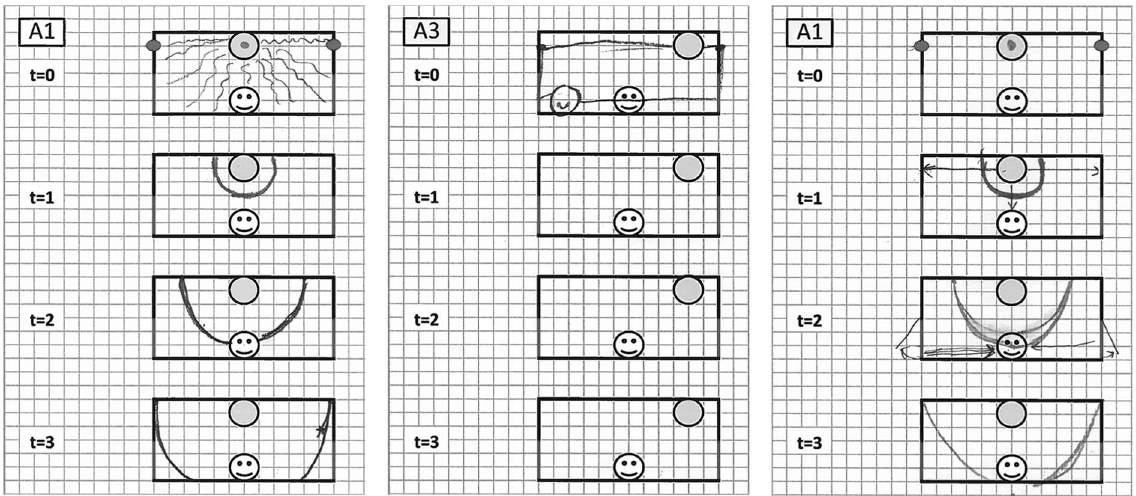
FIG. 4. Participants used EDs in several ways. Light going in all directions (left-hand ED), indication of the path light covers (middle ED), and individual time units for different events (right-hand ED). The semicircles represent wave fronts. How to draw wave fronts is part of the instruction on working with EDs in subtask